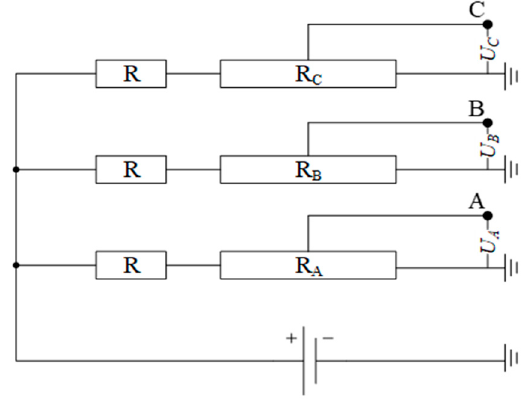
Figure 6. The equivalent circuit of the proposed sensor.